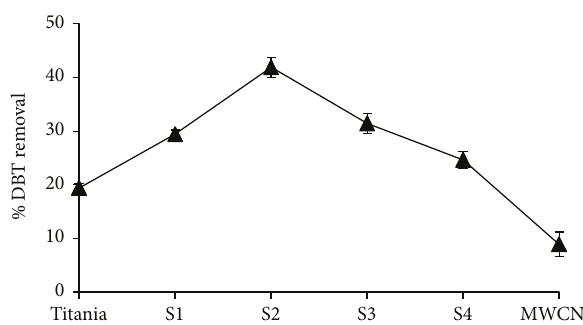
Table 1: Actual and coded values of independent variables. Factor